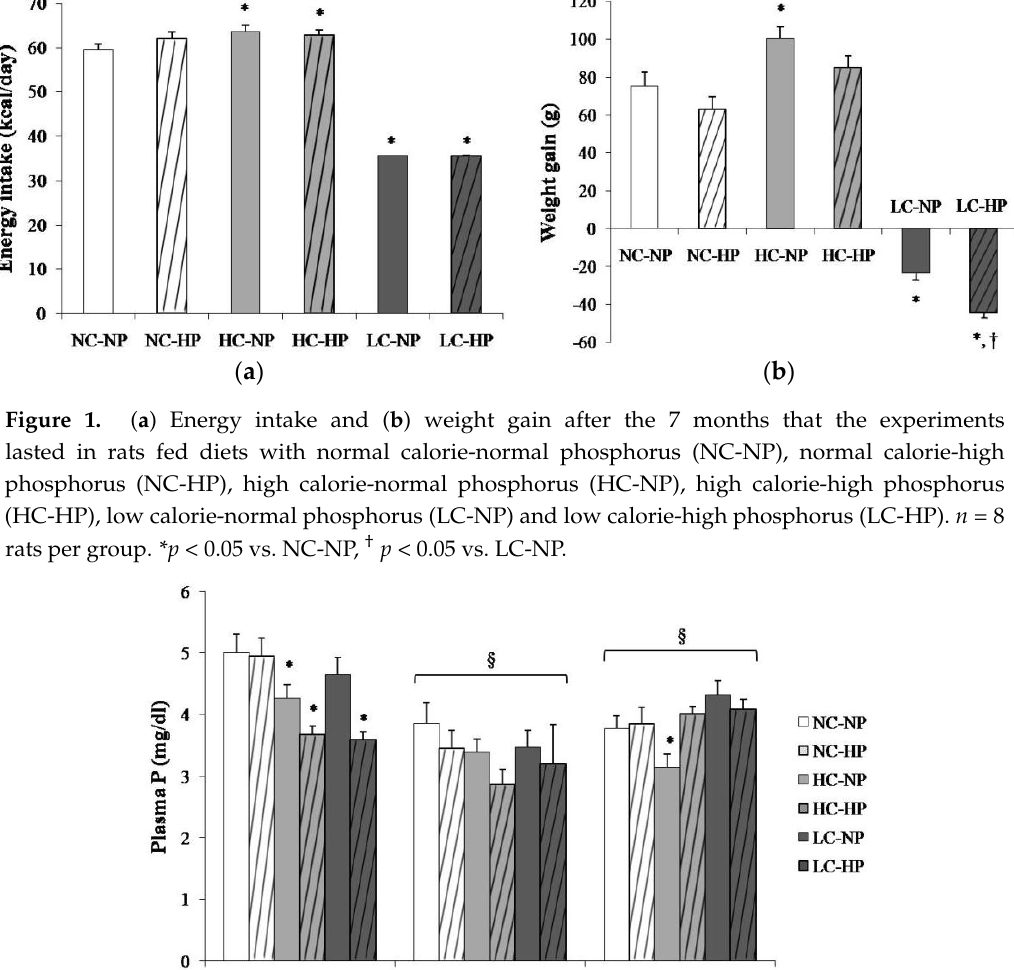
Values are mean ± standard error (SE). * p < 0.05 vs. NC-NP, † p < 0.05 vs. HC-NP, ‡ p < 0.05 vs.